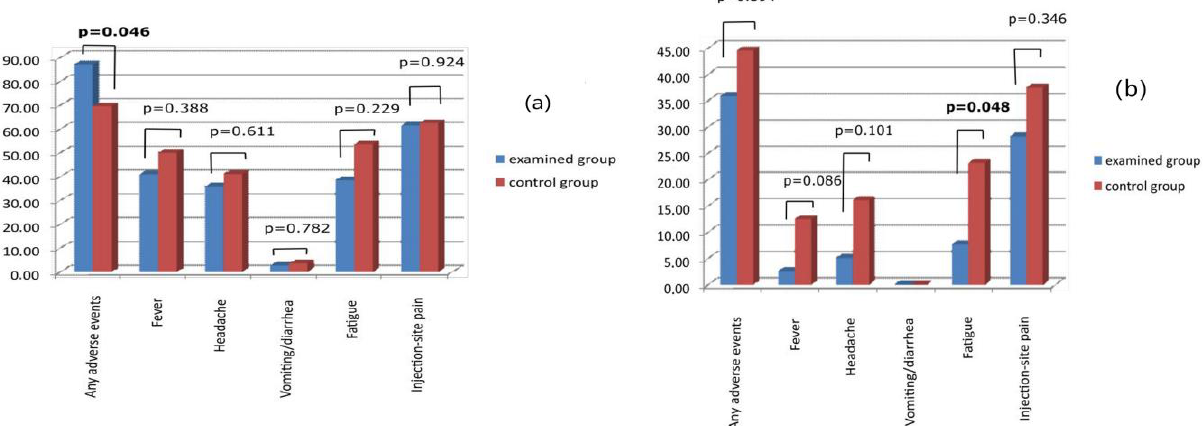
Figure 2. Adverse events after the: ( a ) first dose of vaccine ChAdOx1-S, ( b ) second dose of vaccine